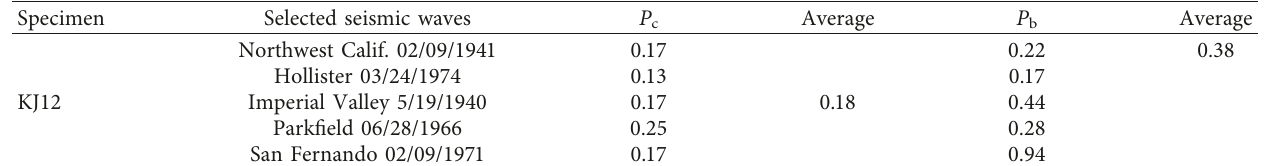
Table 24: Plastic hinge rates of beams and columns in model KJ12.